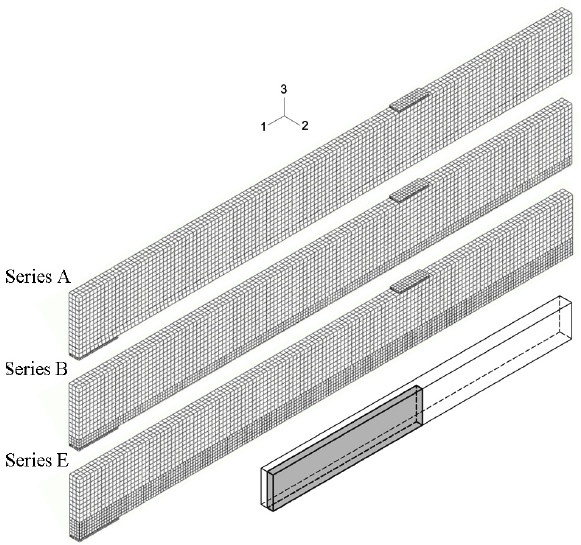
Fig. 4. Mesh discretisation for unreinforced (Series A) and reinforced (Series B and Series E) beams